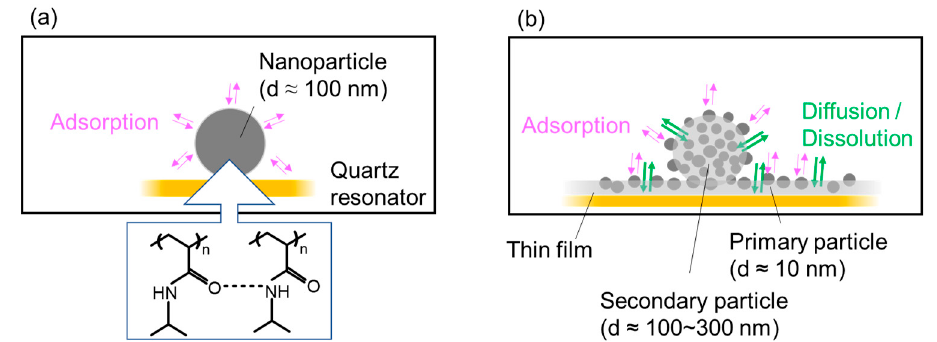
Figure 9. HCl gas adsorption/desorption mechanism: ( a ) nanoparticle coating from pure water solvent; ( b ) nanoparticle coating from water-methanol binary solvent.